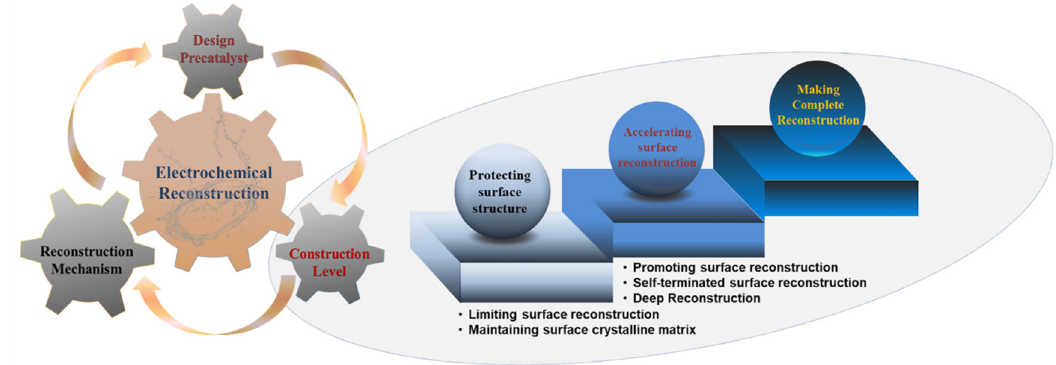
Figure 1. Schematic diagrams of strategies used to control the surface reconstruction process for advanced OER electrocatalysts.